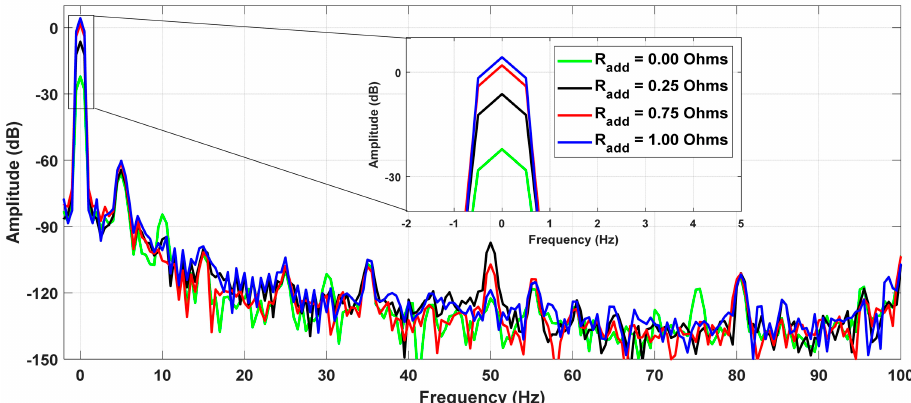
Figure 10. Experimental results: spectra of the proposed fault index under healthy and di ff erent HRC conditions a ff ecting Phase